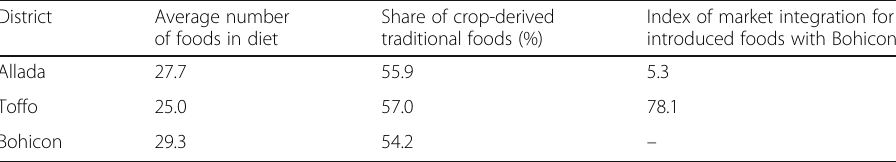
Table 7 Share of traditional foods in diets and market integration for introduced foods